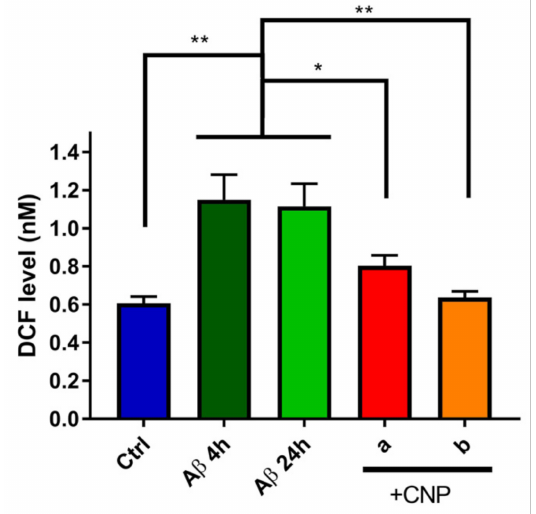
Figure 3. Scavenging activity of cerium oxide nanoparticles (CNP) towards A β -induced free radical species. The fluorescence of dichlorodihydrofluorescein (DCF), which is proportional to the level of ROS/RNS species in the samples, was measured under basal condition, after incubation with A β oligomers (1 µ M) for 4 and 24 h and after addition of 50 µ g/mL CNP (“a” = 1 h A β alone + 3 h in the presence of CNP; “b” = 21 h A β alone + 3 h in the presence of CNP). Ctrl: mean of DCF levels of untreated cells after 4 or 24 h in culture. Data are expressed as mean ± SD from three independent experiments. Statistical analysis was performed using one-way ANOVA: * p < 0.05; ** p < 0.01.